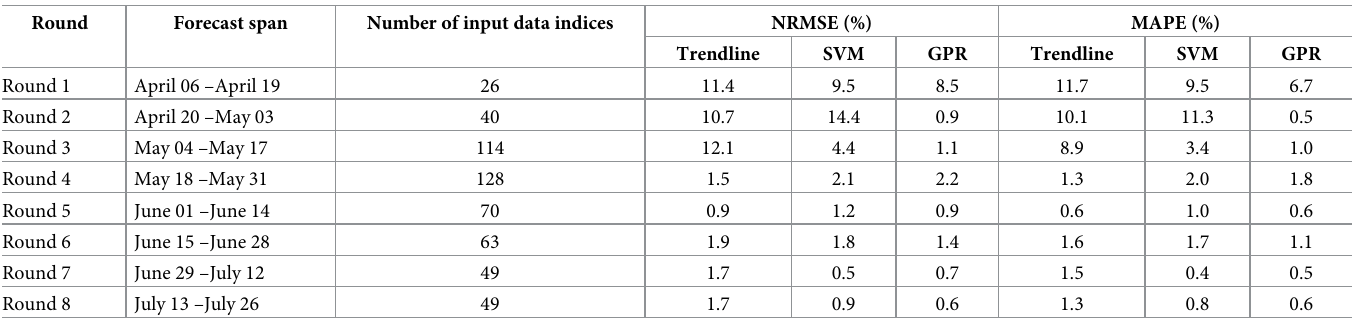
Table 1. Models configuration and overall